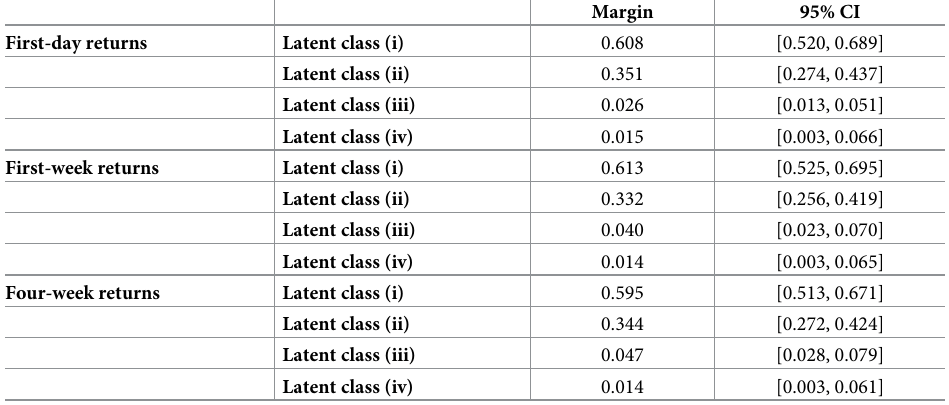
Table 9. Predicted latent class probabilities using first-day, first-week and four-week returns on the issuing firms’ securities.